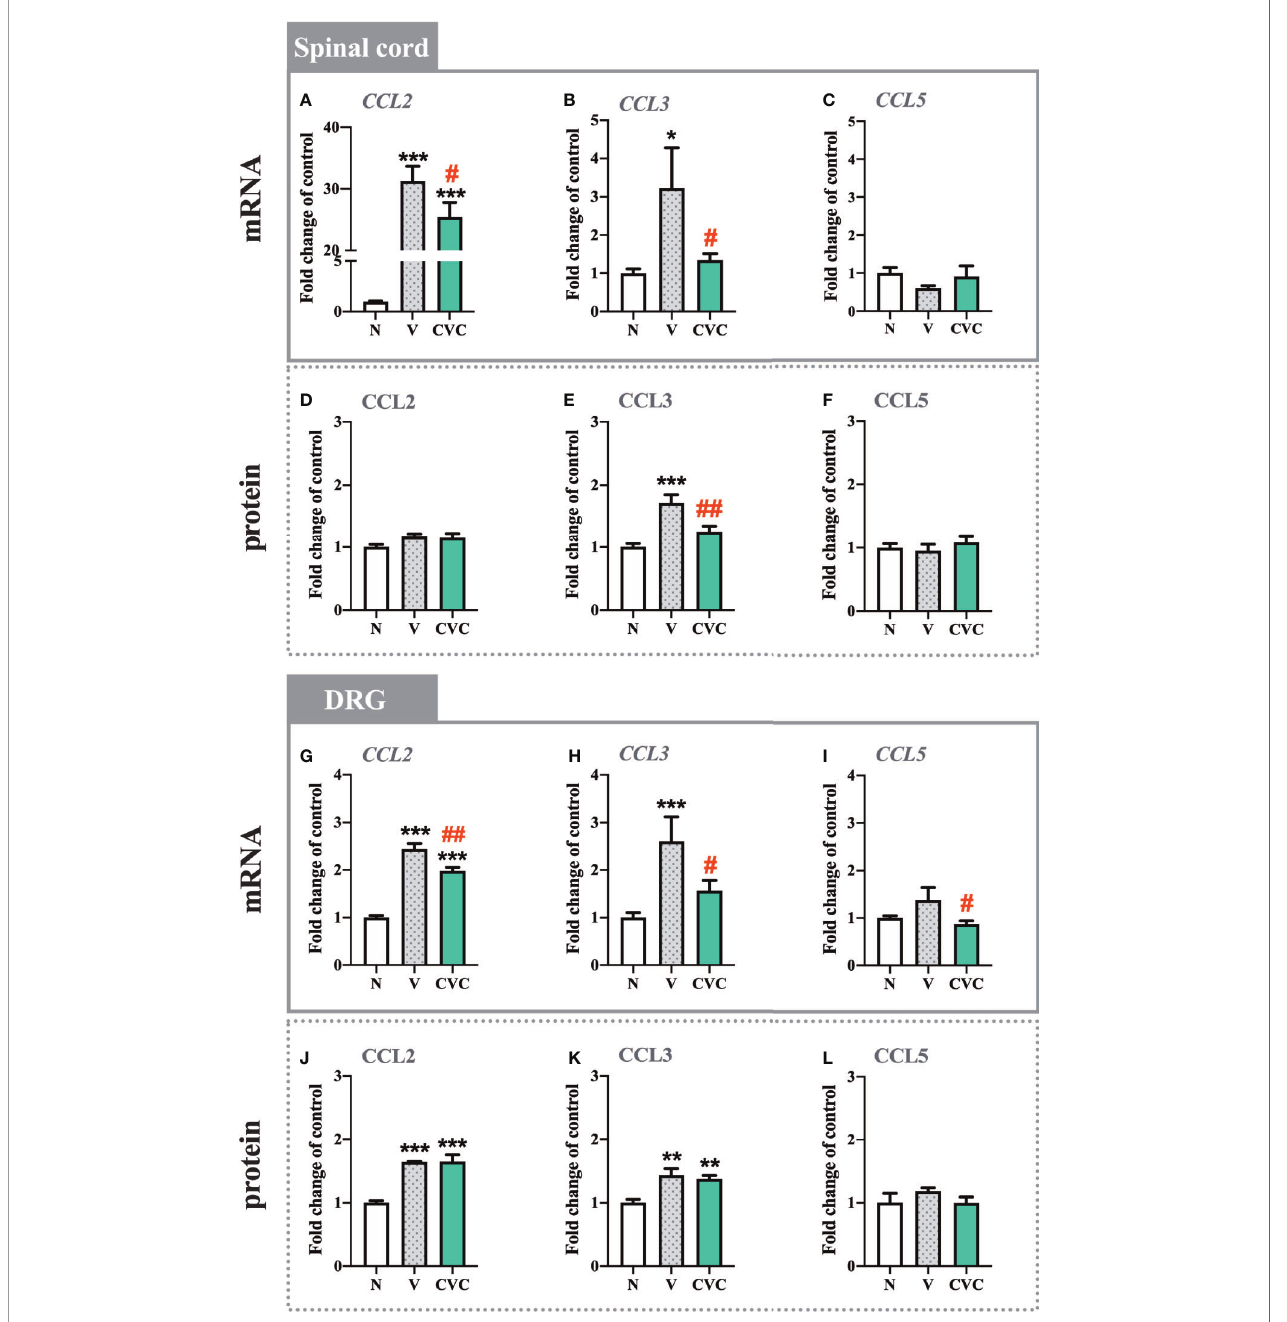
FIGURE 5 | Changes in mRNA (A – C, G – I) and protein (D – F, J – L) levels of CCL2, CCL3 and CCL5 in the spinal cord (A – F) and DRG (G – L) on day 7 post CCI after repeated vehicle or cenicriviroc (20 µg/5 µl, i.t. ) administration, measured using RT-qPCR and Luminex Assays. Data are presented as the mean ± SEM (n = 5 – 8 per group for mRNA analysis and n = 5 – 7 per group for protein analysis). Intergroup differences were analyzed by ANOVA with Bonferroni ’ s multiple comparisons test. ***p < 0.001, **p < 0.01, *p < 0.05 indicate differences between naive and V-treated/CVC-treated CCI-exposed rats; ## p < 0.01, # p < 0.05 indicate differences between V-treated and CVC-treated CCI-exposed rats. CCI, chronic constriction injury; CVC, cenicriviroc; N, naive; V,